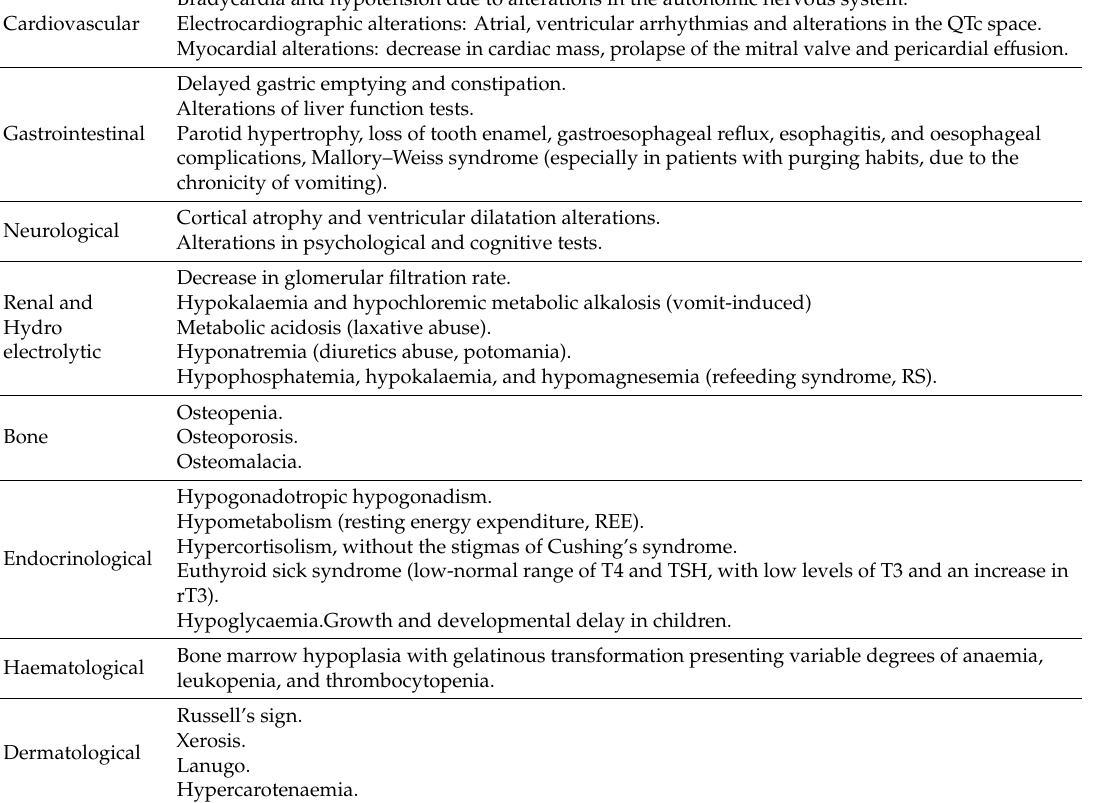
Table 2. Clinical manifestations of anorexia